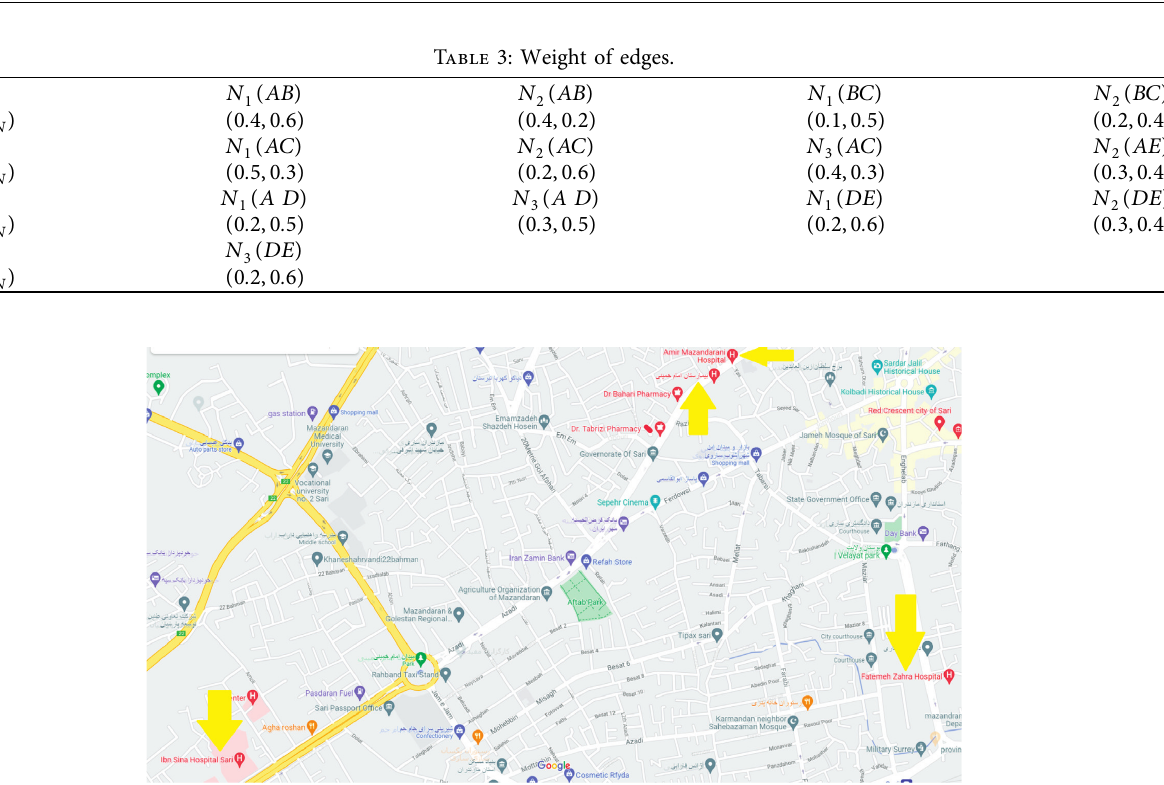
Figure 6: Location of hospitals in Sari city.